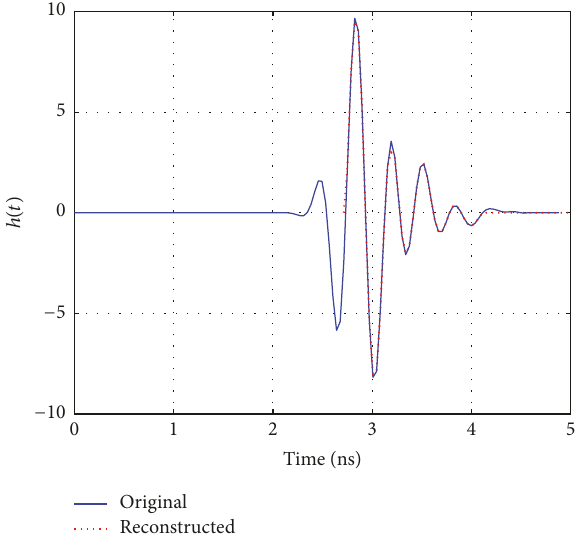
Figure 15: Comparison of the original impulse response and the reconstructed response of the CPW antenna.